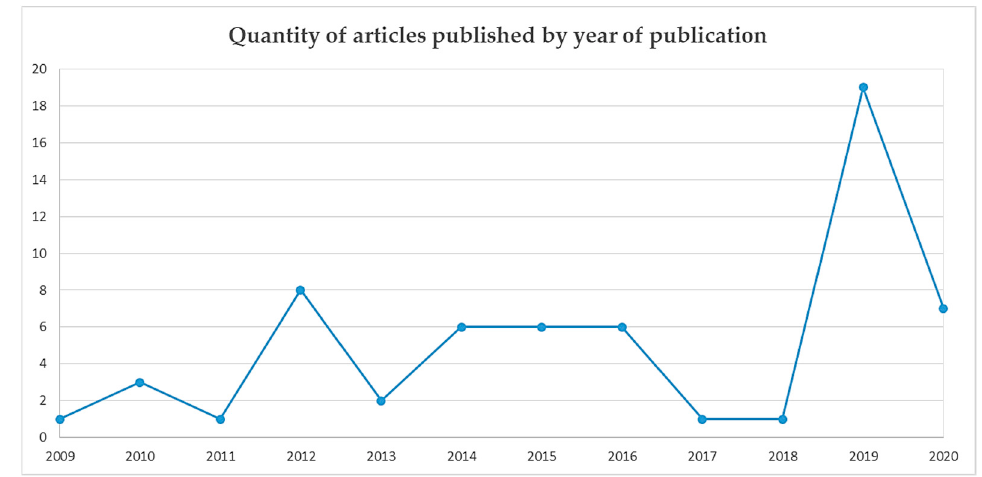
Figure 2. Graph illustrating the number of articles published over